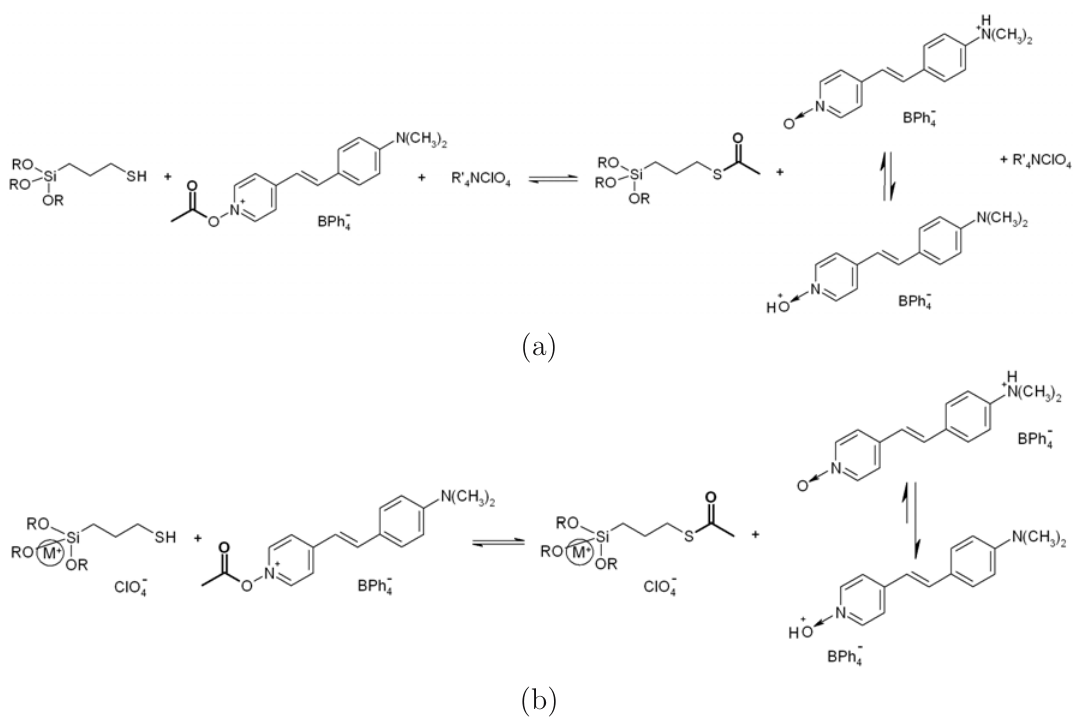
Fig. 5 Mechanism of acyl transfer processes conducted in acetonitrile when (a) the nucle- ophilic ionophores do not form complexes with the ion; and (b) the nucleophilic ionophores form complexes with the